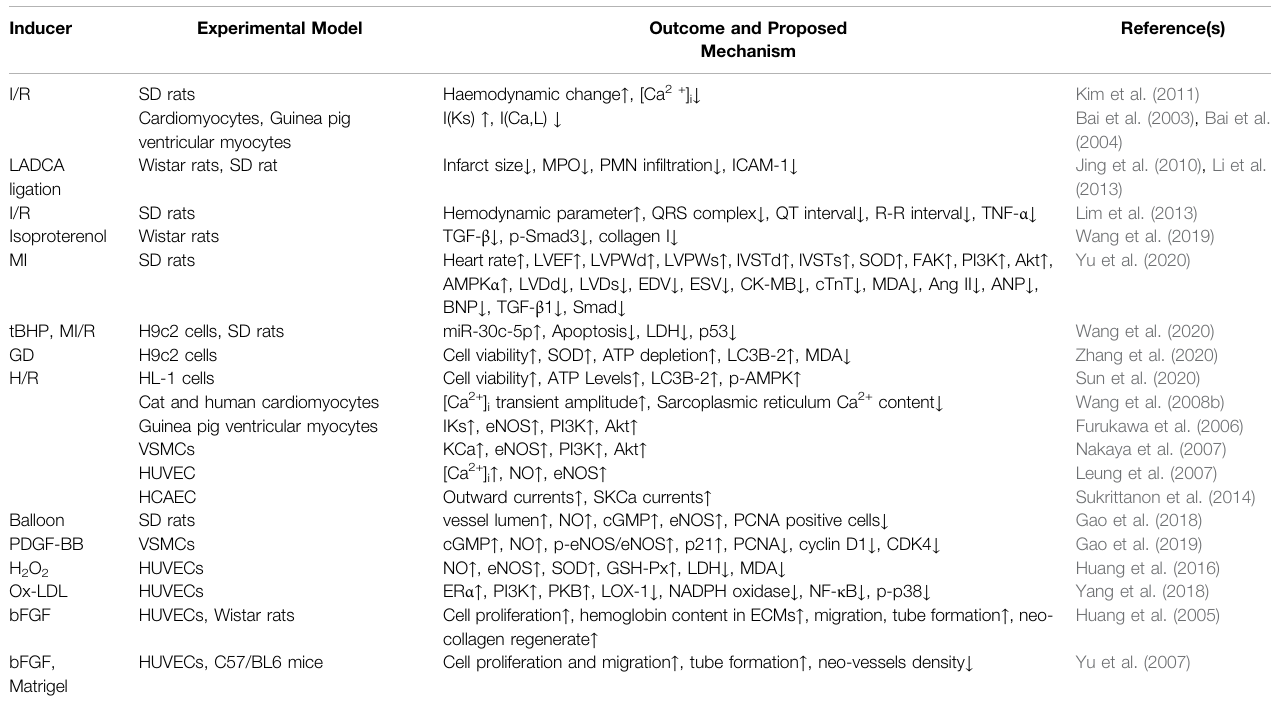
TABLE 4 | Summary of cardiovascular disease effects of Re.